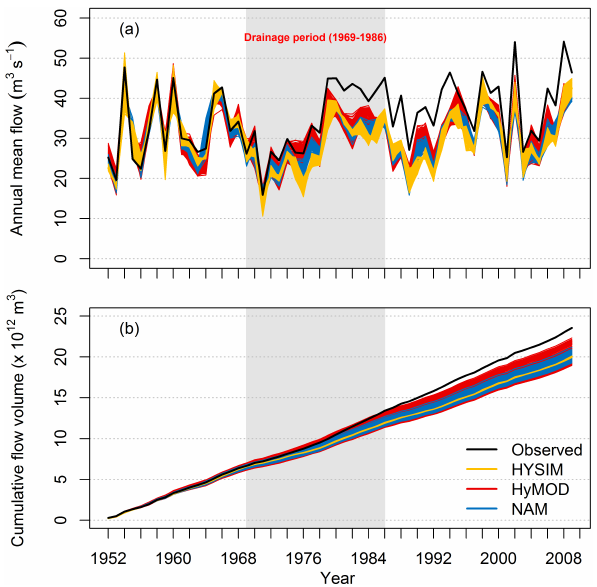
Figure 5. Annual (a) mean and (b) cumulative volume of recon- structed and observed flow for 1952–2009. The period of drainage works is shown by the shaded grey area. Behavioural simulations for each model structure are